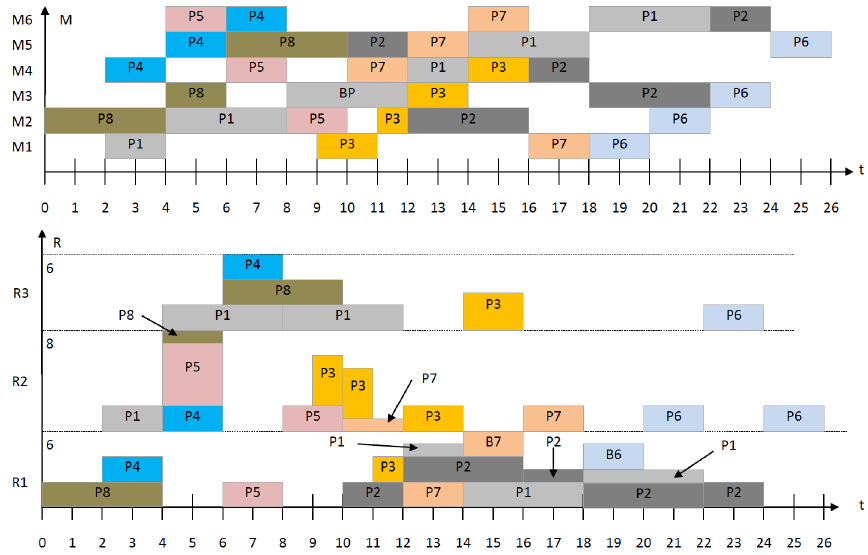
Fig. 5. Gantt charts which visualize the answer to the question Q 1 (upper one: the allocation of machines and lower one: the use of additional resources).